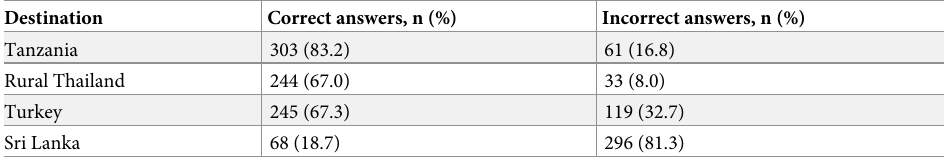
Table 3. Primary care physicians’ knowledge of the recommendation of malaria chemoprophylaxis for most adults travelling to frequent destinations from Qatar (N =